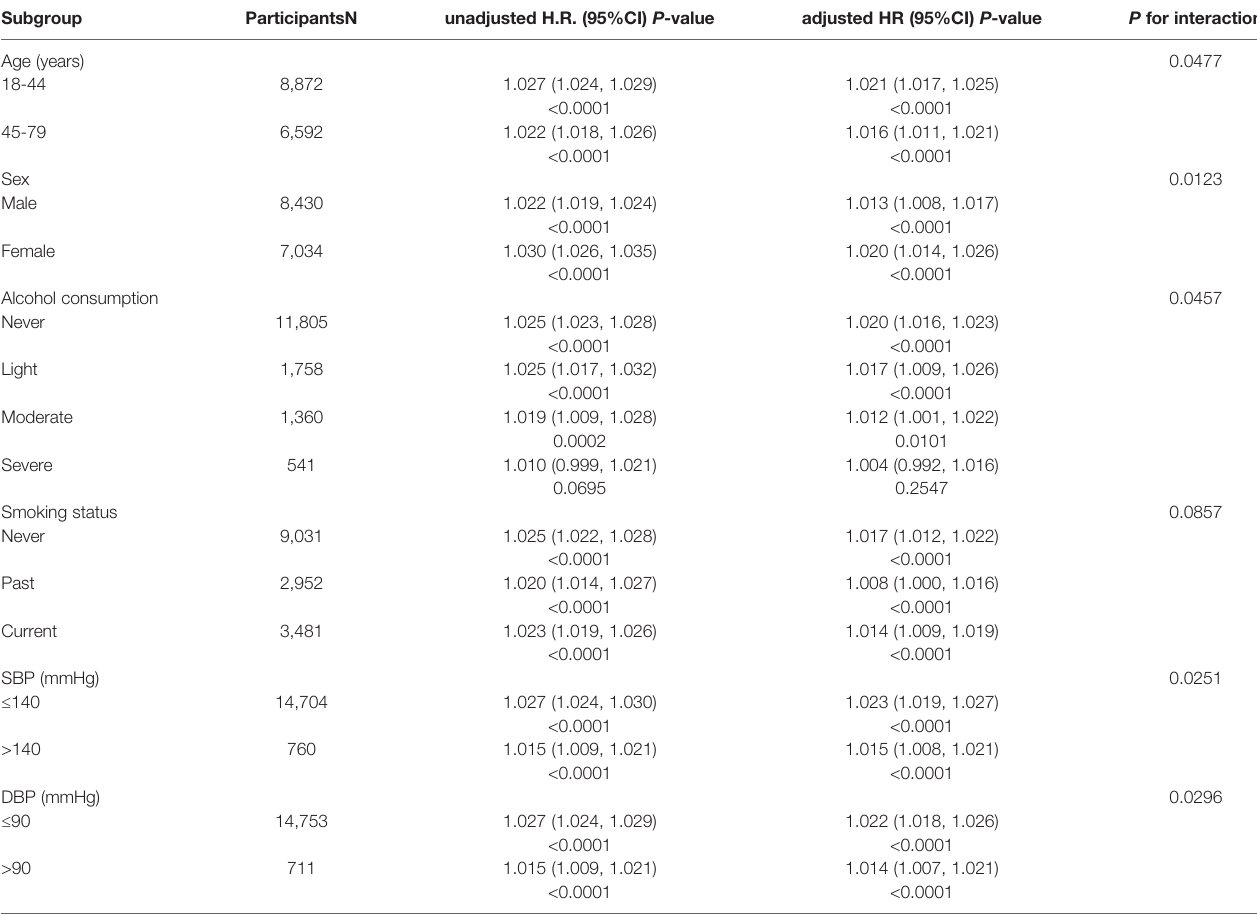
TABLE 3 | Strati fi ed association between TyG-BMI and diabetes by age, sex, alcohol consumption, smoking status, SBP and